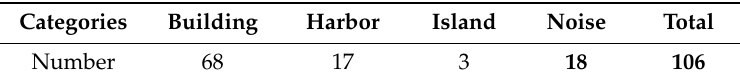
Table 4. The categories of false